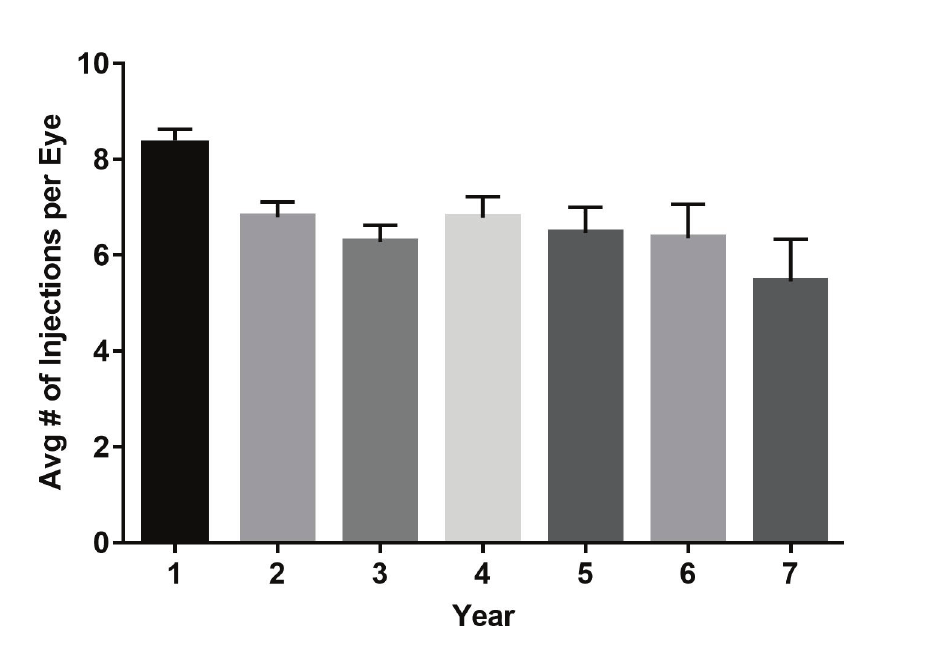
Figure 3. Number of injections over time. The figure shows the average annual number of injections administered over time.